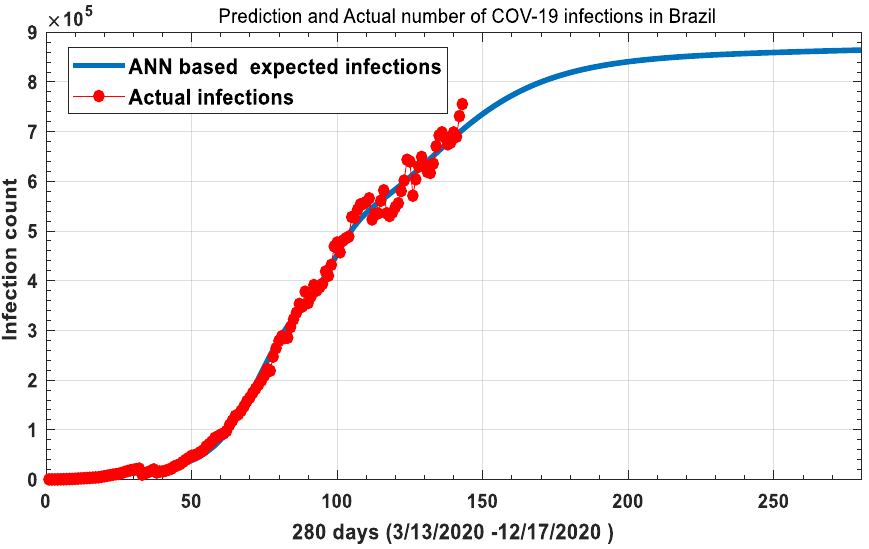
Figure 3. The training data and predicted data of COVID-19 infected people in Brazil. Figure 4 represents the training data (in Red), and ANN-based predicted data (in Blue) of recoveries from COVID-19 in Brazil, where the training data covers the duration of recovered cases would increase by the end of the current year, at 15 × 10 5 daily rate. On the other hand, Figure 5 shows that the number of death cases would increase by the end of the current year, at 6.5 × 10 5 daily rate. Note that the training data (deaths data) covers